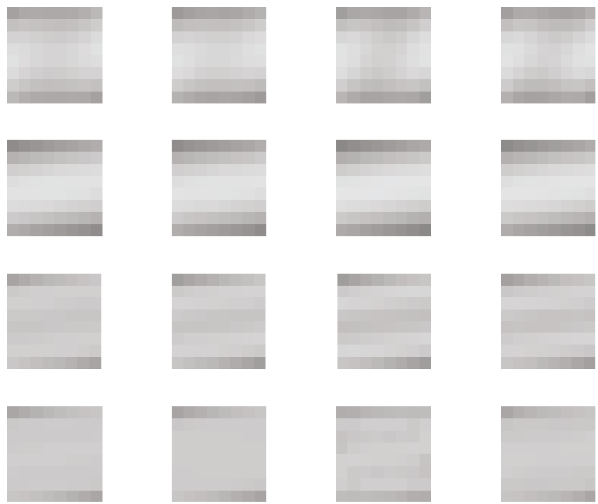
Figure 5: Some of the similar energy blocks (4 similar energy blocks from left to right in each set).